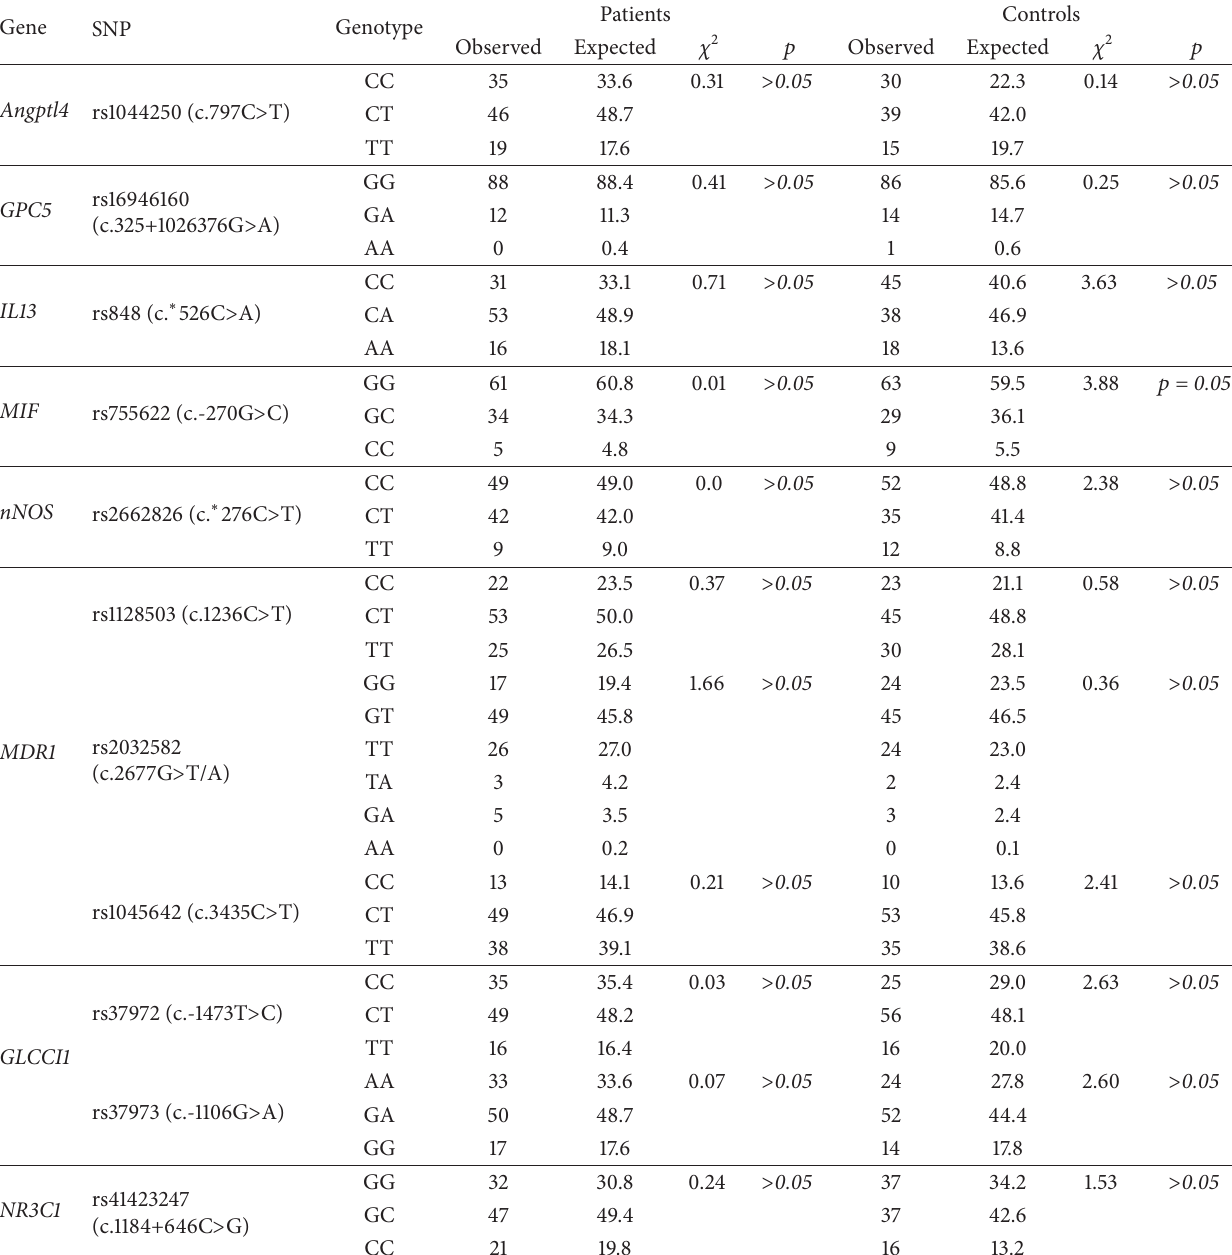
Table 2: The distribution of observed and expected genotypes. 𝑝 values of 0.05 or above signal consistency with the assumptions of the Hardy-Weinberg